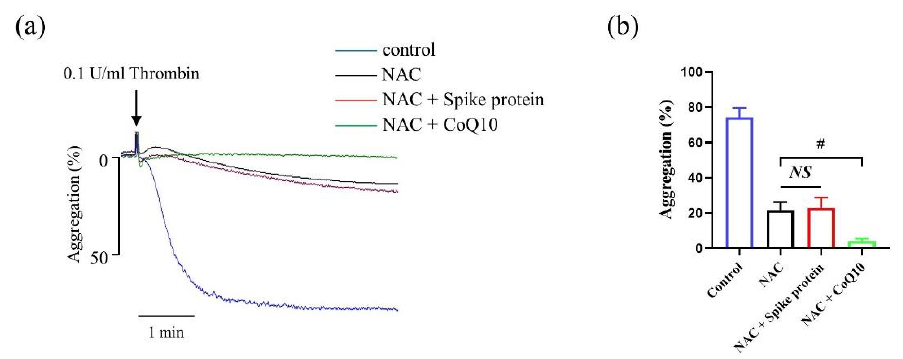
Figure 8. The effect of Spike protein on potentiating platelet aggregation is via ROS-mediated signaling pathway. Human gel-filtered platelets were incubated with 1 mM NAC for 20 min, then incubated with spike protein for 10 min or CoQ10 for 50 min. All the samples then were activated with 0.1 U/mL thrombin, and the platelet aggregation was monitored for 5 min. ( a ) Representative traces and ( b ) summary data were presented ( n = 6). Data are presented as mean ± SEM. # p < 0.05 indicates a significant difference between two groups. NS , no significant difference between two groups.